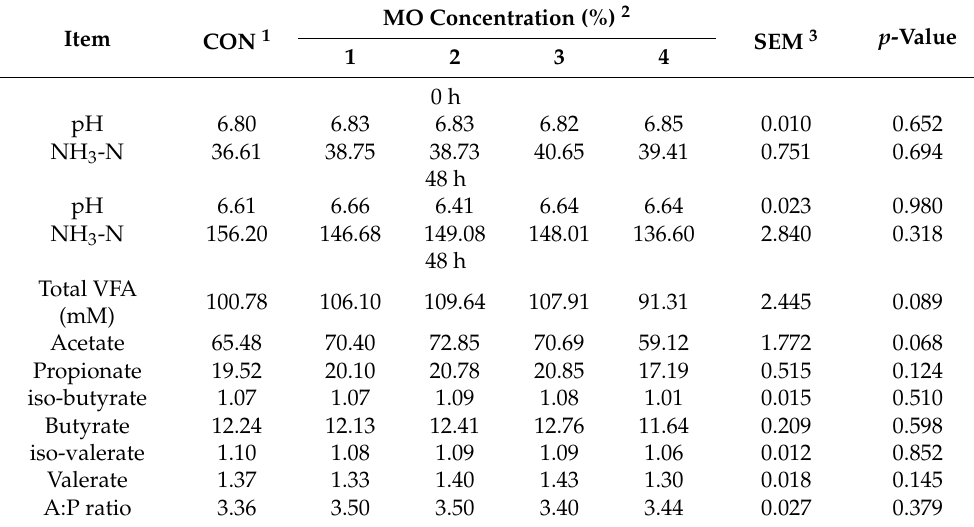
Table 2. Effect of 3% rumen-protected microencapsulated supplement (MO) on pH and ammonia-N and volatile fatty acid (VFA) contents in the in vitro rumina fluid.